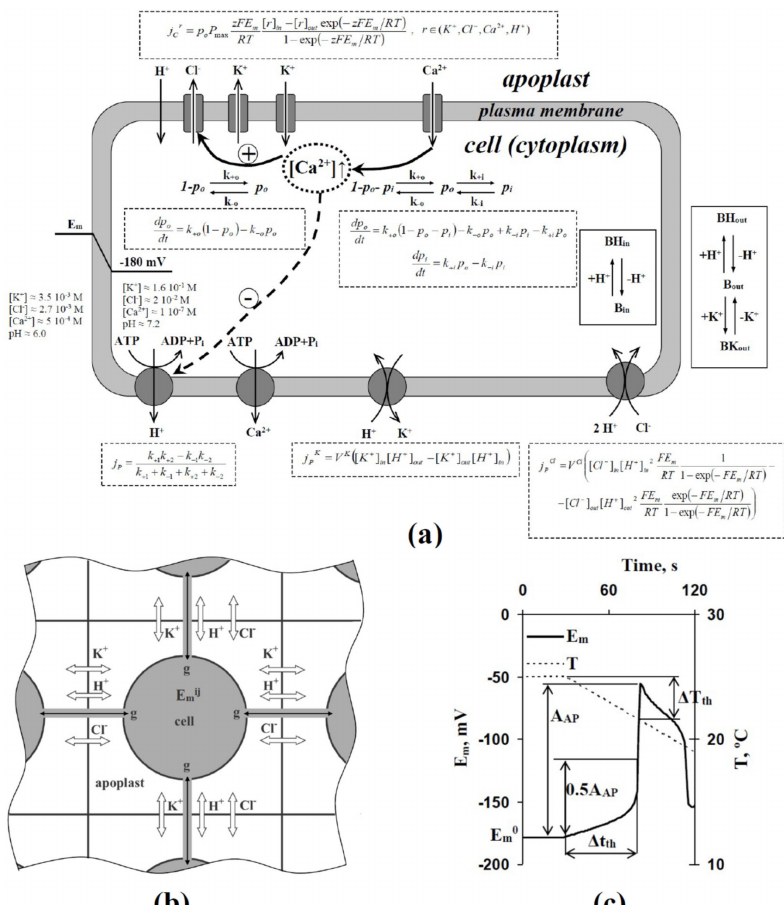
Figure 1. ( a ) Schema of the model of the generation of the cooling-induced electrical response (action potential in irritated zone, AP), ( b ) schema of interaction between neighboring cells, ( c ) and basic parameters of AP used in the current work. The model was based on our previous studies [11,29,53,57–59]; equations of the model are described in the File S1